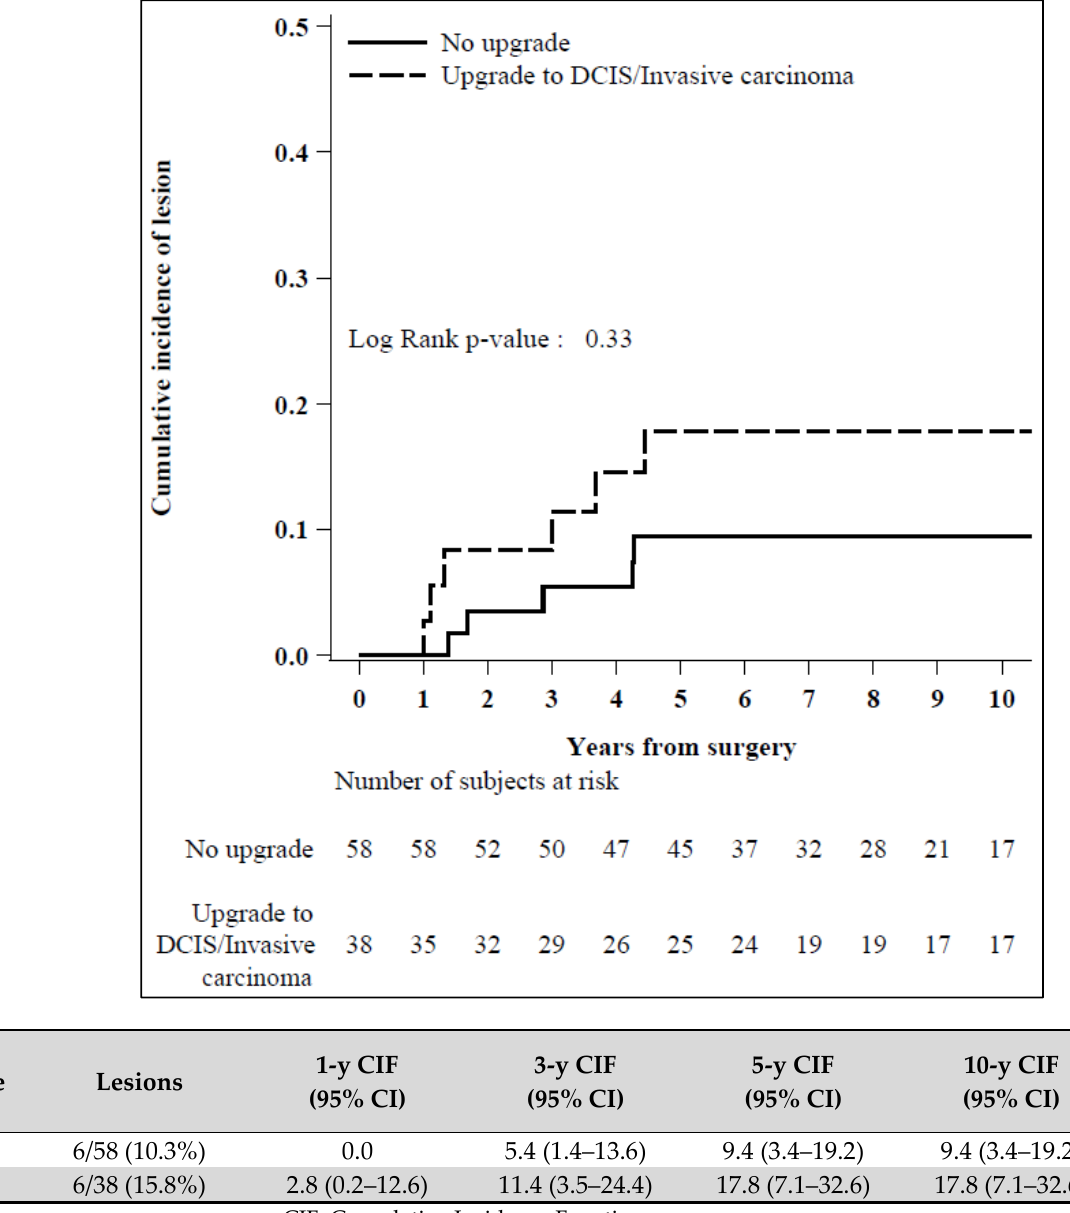
Figure 4. Cumulative incidence of lesion by upgrade to carcinoma in situ or invasive carcinoma (N =